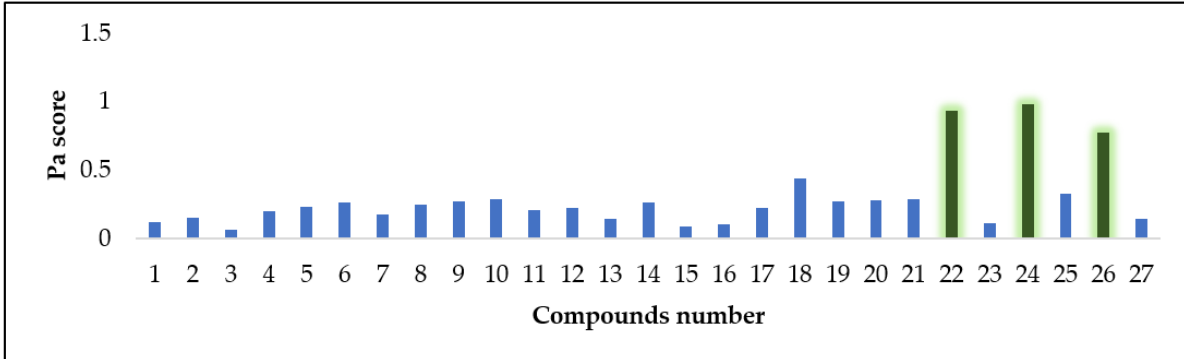
Figure 14. Predicted antioxidant activity scores for compounds 1–27 (Pa scores): Pa scores > 0.5 indicate high probability to show antioxidant activity in-vitro, while Pa scores < 0.5 indicate high probability to be an antioxidant agent in-vitro.